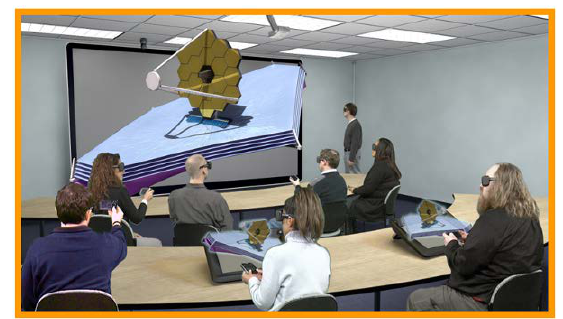
Figure 12. Immersive Interactive Classroom Concept (learners can interact with the 3D model on the large screen, with 3D virtual holographic displays on tablets, and with other in- formation on smart mobile devices) See ESM2 Figure 13. Animation showing Eon Reality Touchless Interface